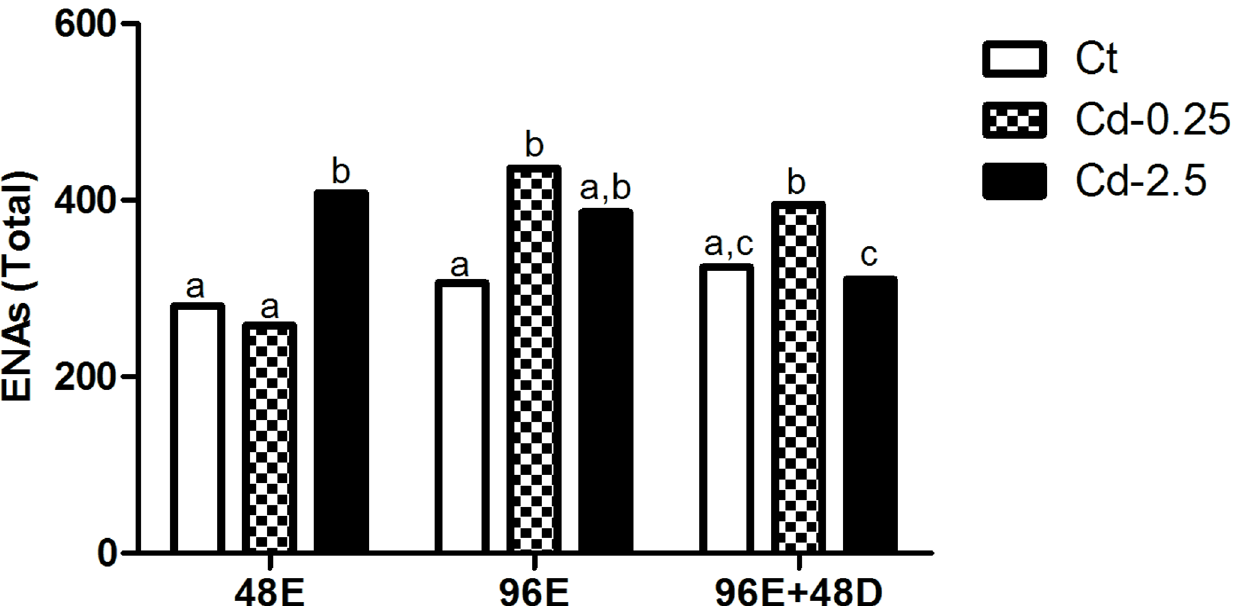
Fig 6. Total number of ENAs in in vivo assay. Values followed by different letters differ by Chi-square test (p < 0.05).